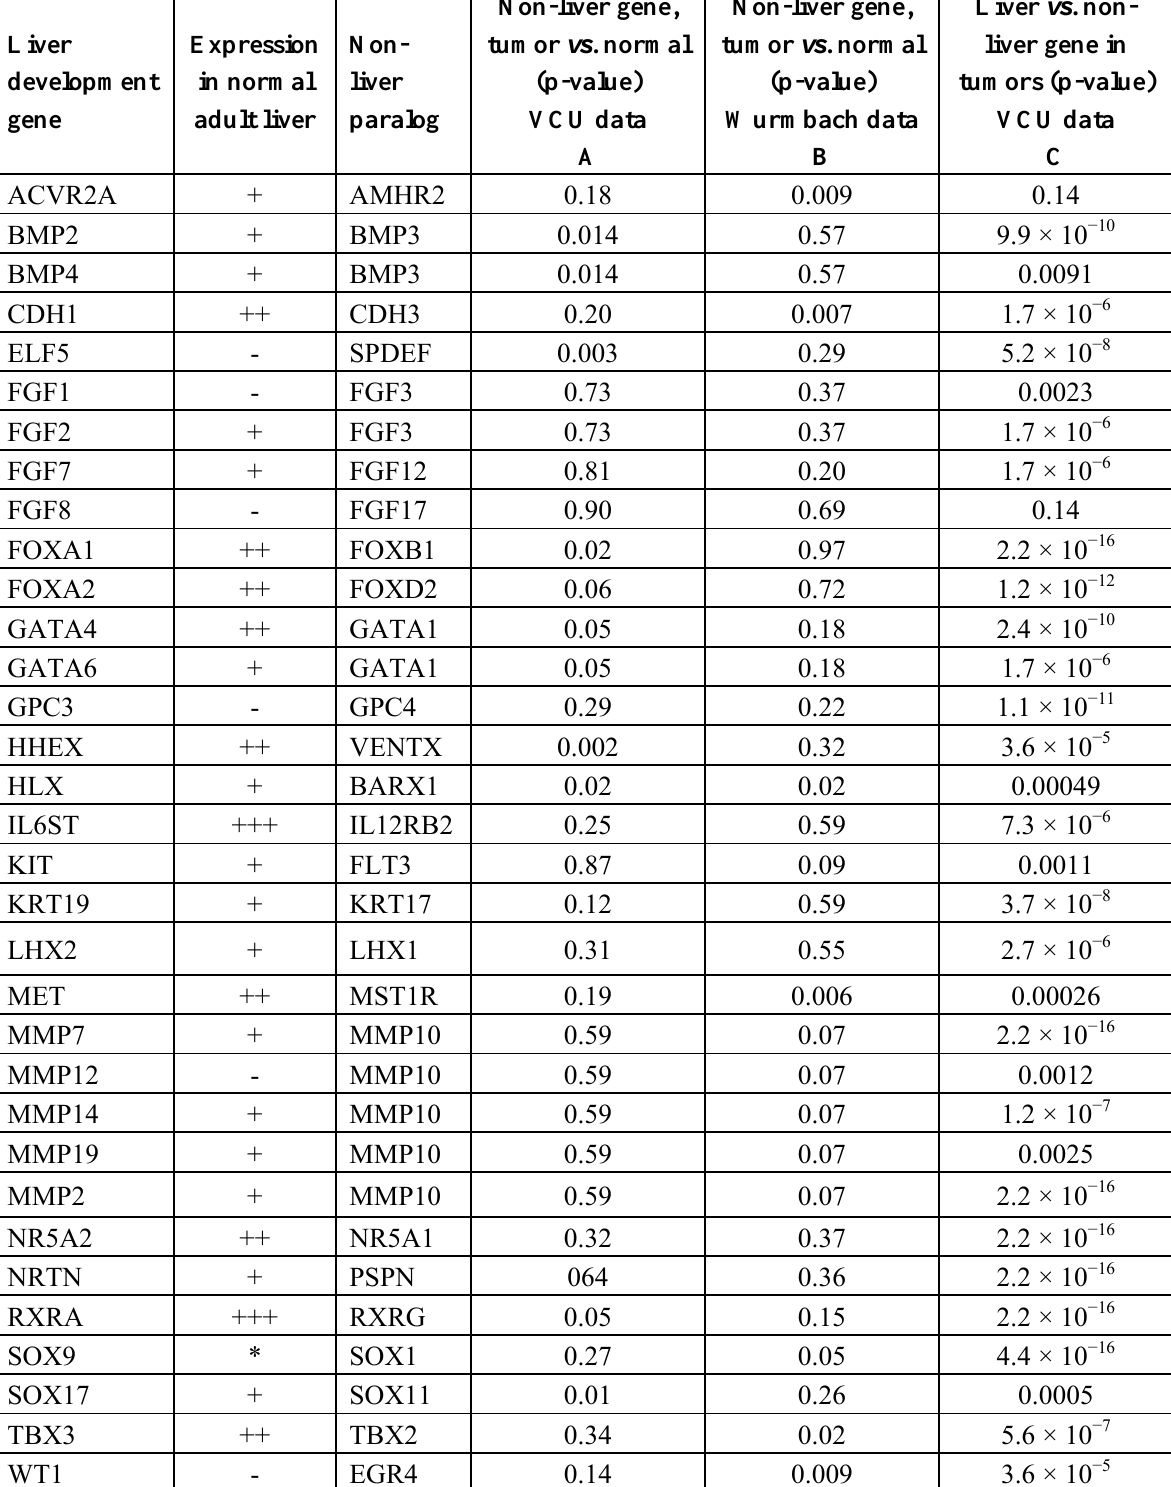
Table S1. Liver development genes compared to their non-liver paralogs. A: one-sided K-S test of identical distribution comparing HCC to normal samples; B: on-sided K-S test in the Wurmbach dataset; C: K-S test comparing the liver development gene to it’s non-liver